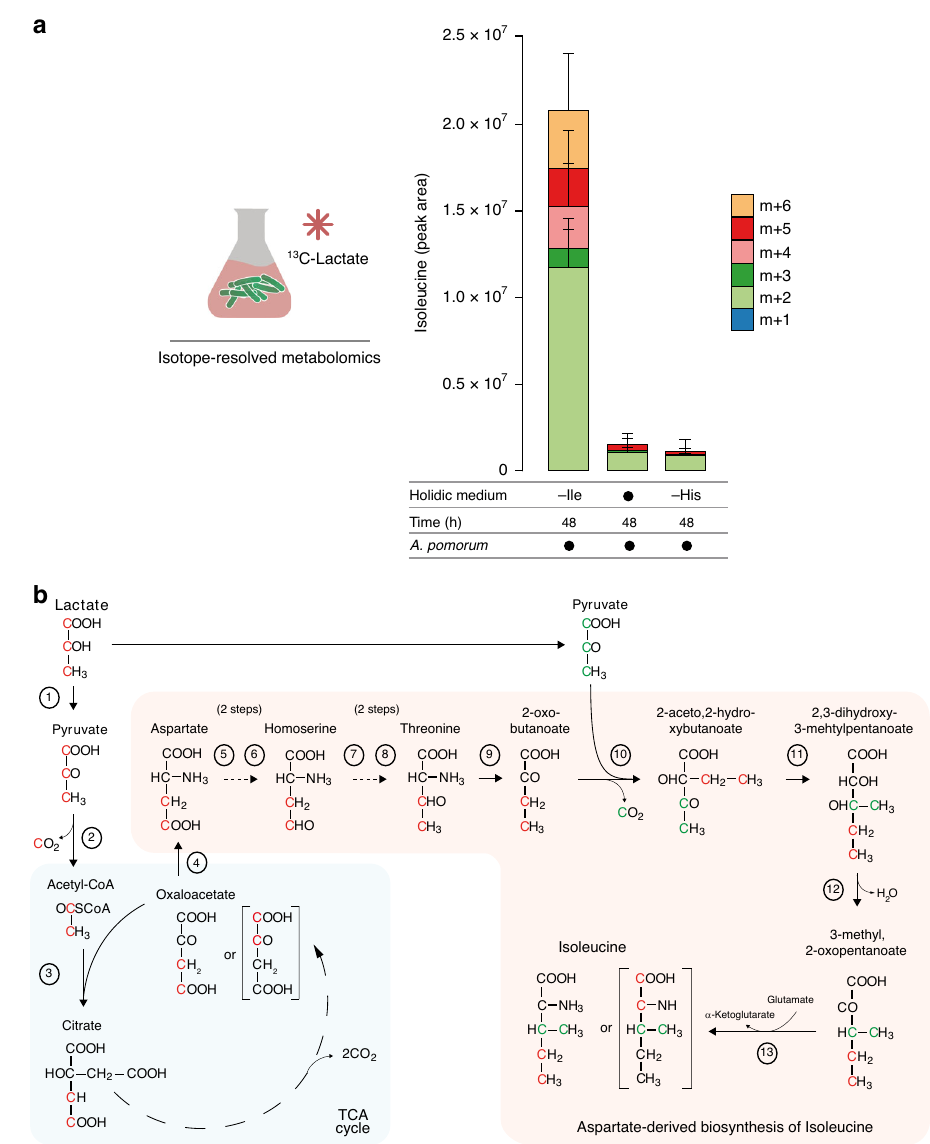
Fig. 5 Ap synthesises Ile from lactate through an aspartate-derived biosynthetic pathway. a The stacked bars represent the relative amount of Ile isotopologues measured in the supernatant of liquid holidic medium of bacterial cultures in complete holidic medium ( fi lled black circle) or in medium without Ile (-Ile) or without His (-His) containing uniformly 13 C labelled lactate ( 13 C-lactate). Heavy-labelled Ile isotopologues were measured using LC – MS in samples collected after 48 h of bacterial growth and displayed as metabolite peak area. The number of heavy carbons incorporated per Ile molecule is indicated as m + n , where m = molecular mass of the metabolite and n = the number of 13 C. Filled black circles represent the presence of speci fi c bacteria in the culture. For each condition 3 independent bacterial cultures were sampled. The plots represent the mean amount of the detected isotopologues per condition and the error bars represent the s.e.m. Source data are provided as a Source Data fi le. b Predicted biosynthetic pathway for the synthesis of Ile from lactate in A. pomorum . Circled numbers correspond to the enzymes and reactions in Supplementary Table 1. The fate of lactate carbon atoms incorporated through the TCA cycle is indicated in red, while the pyruvate (derived from lactate) carbon atoms incorporated by enzyme 10 are labelled in green and red. Note that the resulting Ile molecule can contain 2 or 4 labelled carbon atoms depending on the labelling of the lactate molecules. Continuous arrows represent direct reactions; dashed arrows represent two or more consecutive